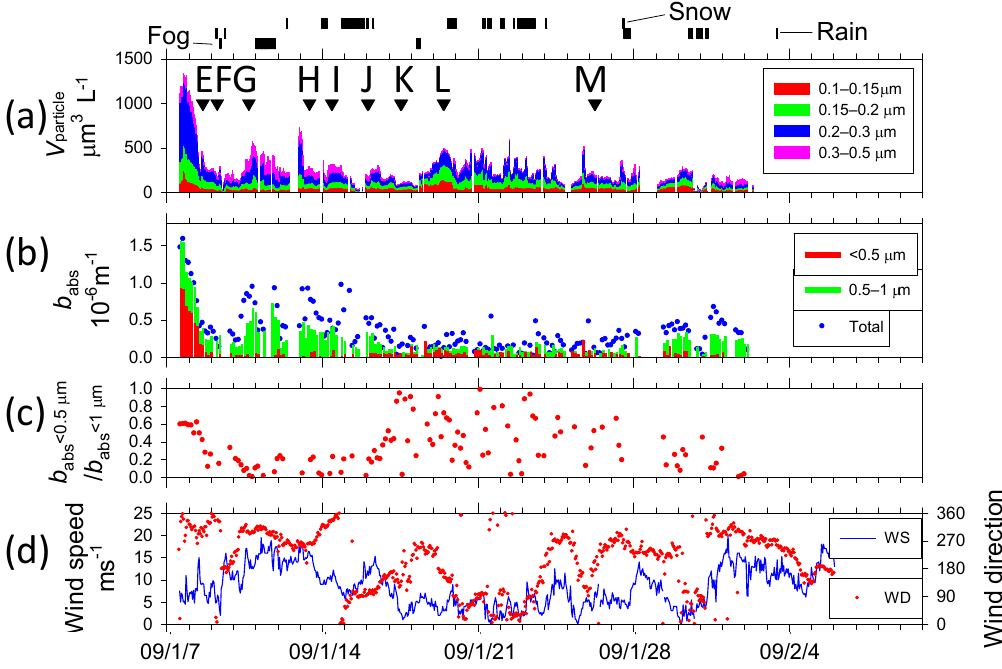
Figure 5. Temporal variations of (a) volume concentration of aerosol particles and start times of TEM sampling (A–M with arrows), (b) ab- sorption coefficient b abs of size-segregated aerosols, (c) ratio of b abs of < 0.5µm to b abs of < 1.0µm particles, and (d) wind speed and direction from Cape Town to Fremantle. Vertical marks above (a) show periods of snow, rain, and fog.